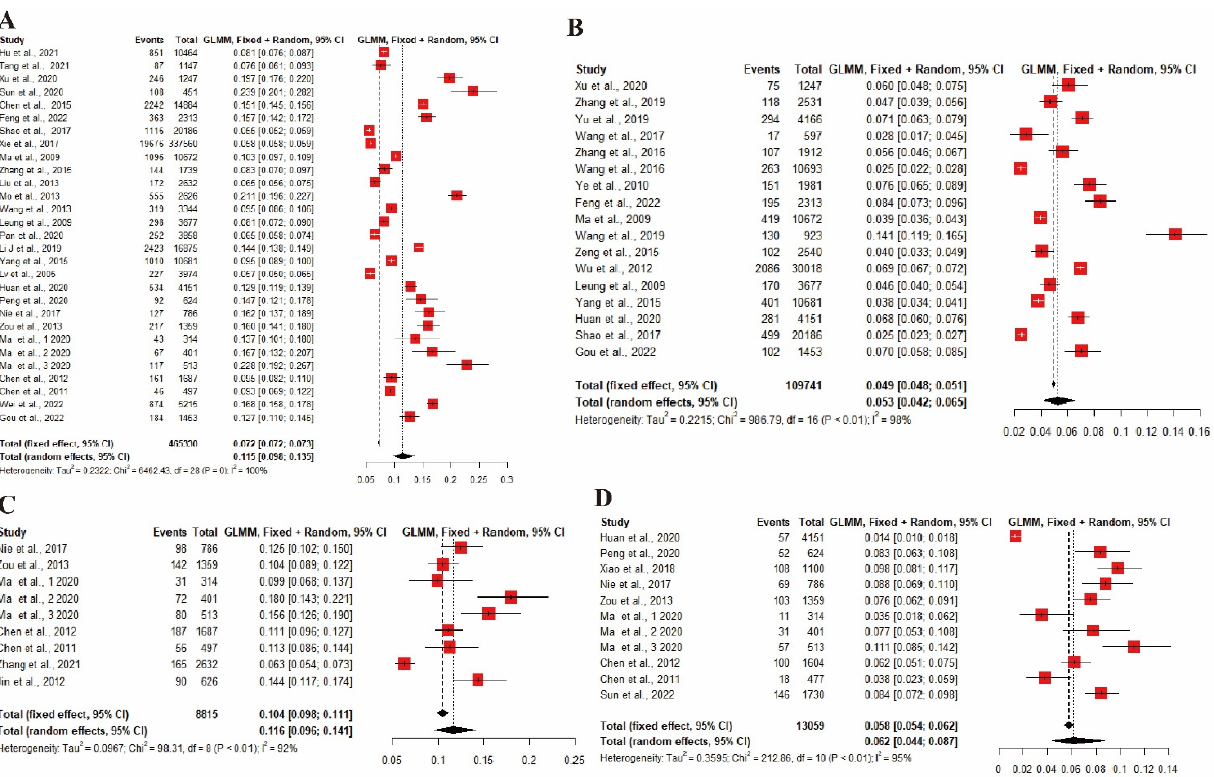
Figure 2. Forest plot of the pooled lifetime prevalence of FA in China. ( A ) Self-reported FA. ( B ) Self- reported physician-diagnosed FA. ( C ) SPT-positive FA. ( D ) OFC-positive FA. FA, food allergy; OFC, open food challenge; SPT, skin prick test.